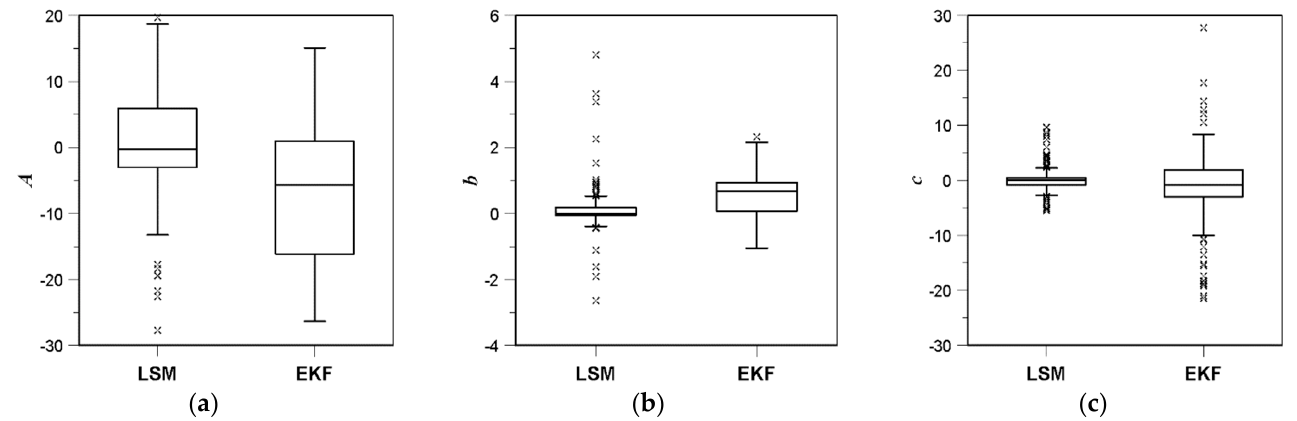
Figure 8. Comparison of box-whisker plots of the estimated parameters at the Shinpo rain gauge station (No. 936) by applying the extended Kalman filter (EKF) and the least squares method (LSM): ( a ) parameter A , ( b ) parameter b , ( c ) parameter c.